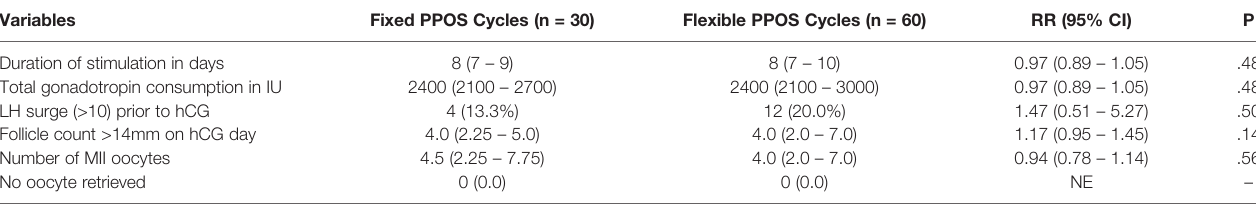
TABLE 2 | Outcome of fi xed and fl exible progestin regimens on ovulation induction